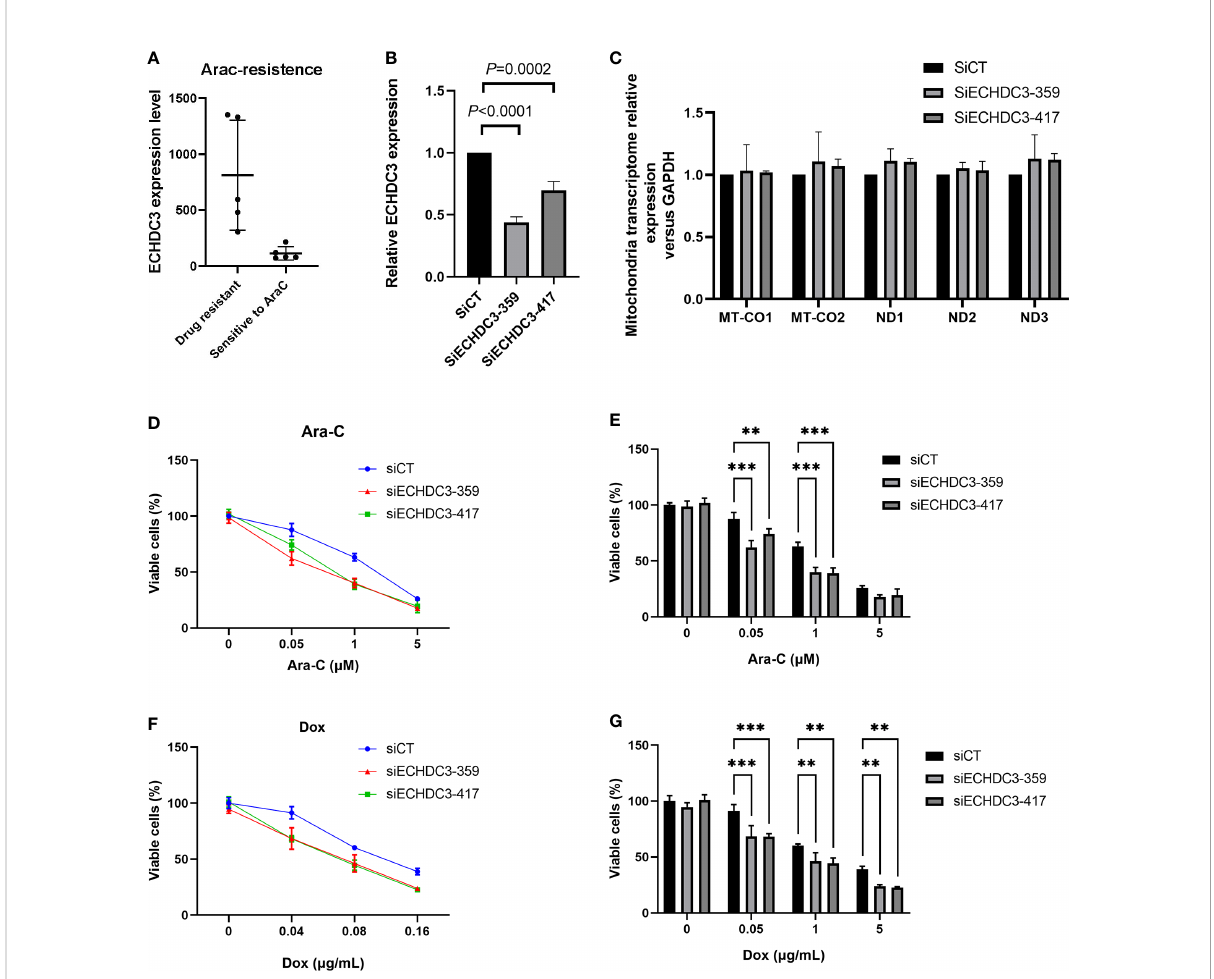
FIGURE 8 ECHDC3 in chemoresistance. (A) Higher ECHDC3 promotes chemoresistance by analyzing the GSE52919 database. (B) Knocking down ECHDC3 by RNAi. (C) Comparison of mt-DNA transcriptome by knocking down ECHDC3. (D, E) Cell viability treated with Ara-C. (F, G) Cell viability treated with doxorubicin. ***P<0.001,